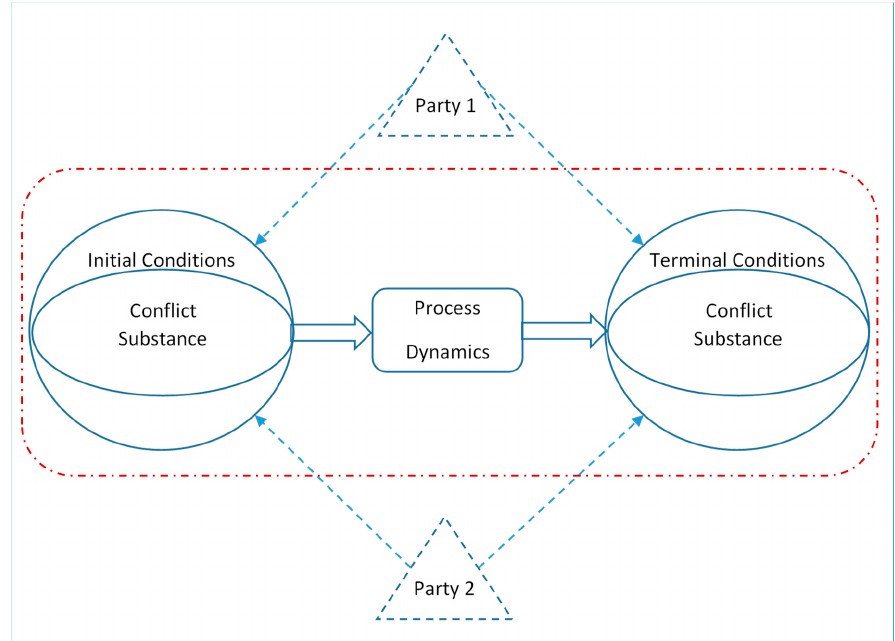
Figure 3. Structure of Simulation Modelling Mechanism. Table 2. Simulation Models—Theory and Implementation.